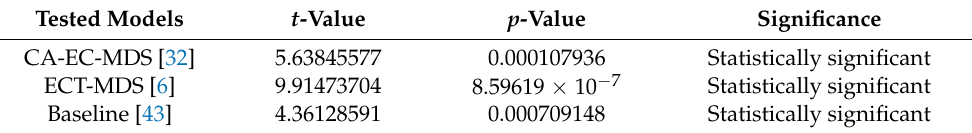
Table 4. The statistically significant of the overall performance